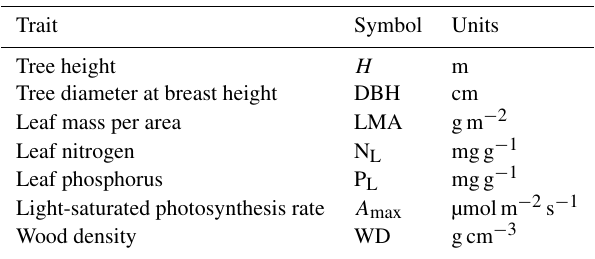
Table 1. Input tree size and leaf and stem traits used by the TFS model.